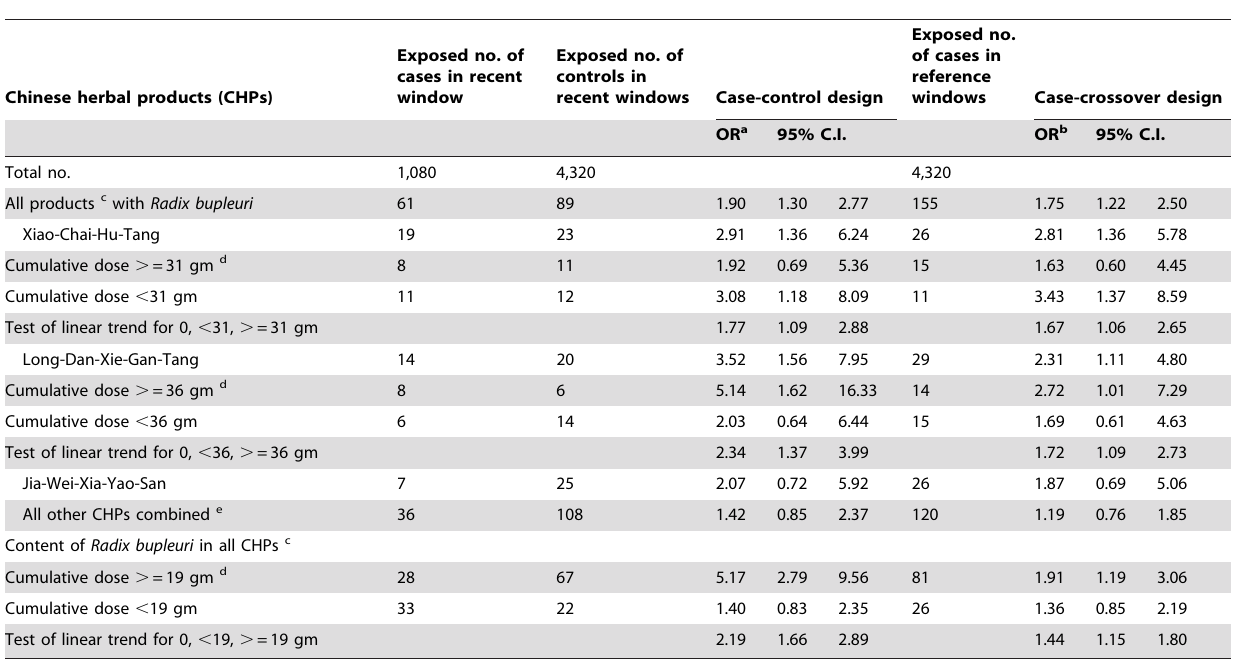
Table 2. Number of exposed subjects with viral hepatitis B in the 30-day windows and adjusted odds ratios between hospitalisations with liver injury and Chinese herbal products with Radix bupleuri by case-control and case-crossover designs, 1997–2004.